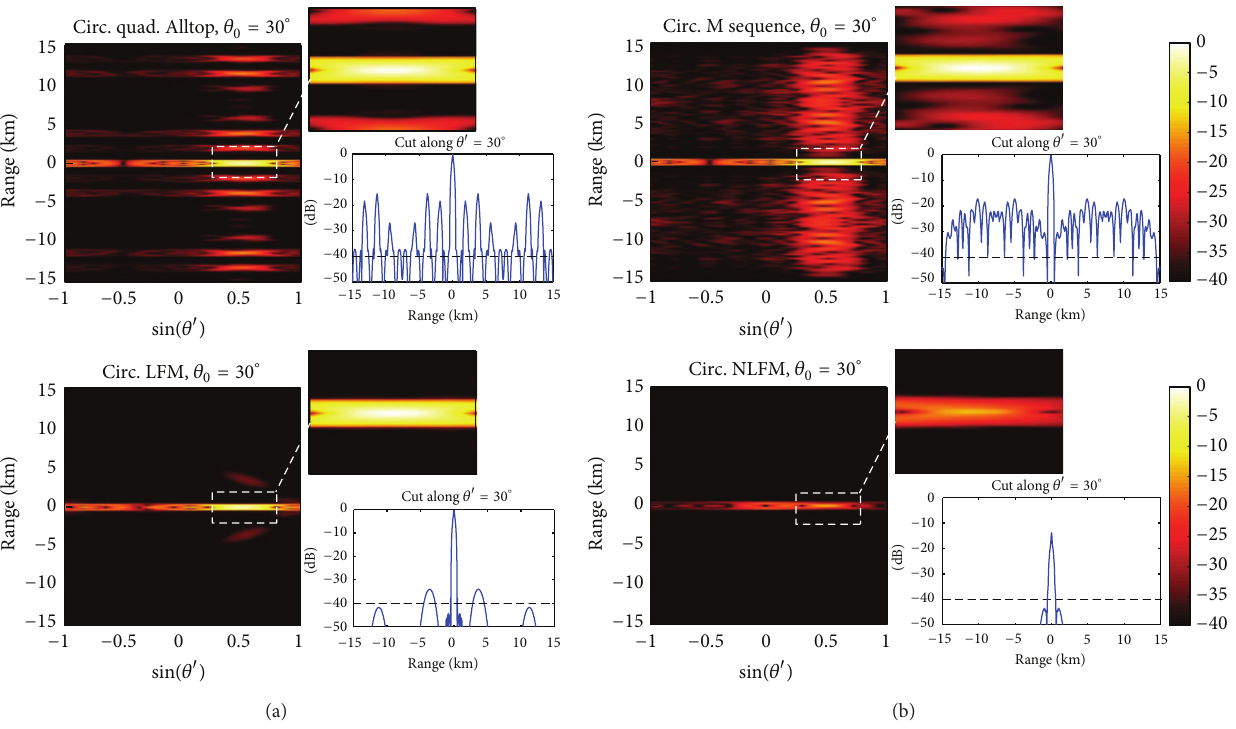
(𝜏 󸀠 , 𝜃 󸀠 )| 2 at 𝜃 = 30 ∘ in 0 0